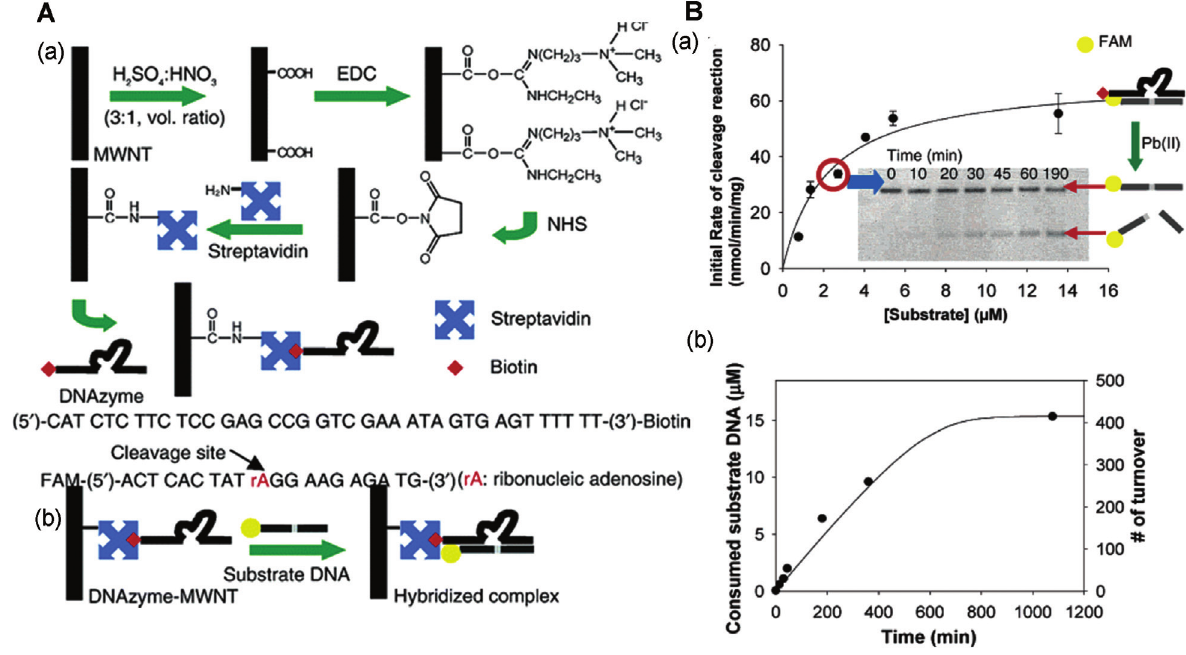
Figure 5 (A): (a) Sequence of the 17E DNAzyme and schematic showing the procedure for immobilizing it onto MWNTs; (b) sequence of 6-carboxyfluorescein (FAM)-bound substrate DNA, which contains a single embedded ribonucleotide (cleavage site), along with a cartoon depicting its hybridization with DNAzyme. (B) Catalytic activity of DNAzyme-MWNT conjugates: (a) initial rate of cleavage of substrate DNA by DNAzyme-MWNT conjugates in the presence of 0.15 mm Pb 2+ ; (b) confirmation of multiple turnovers by DNAzyme catalysis initiated with 0.15 mm Pb 2+ at room temperature. Reprinted with permission from: Yim et al. 2005. Copyright 2005, American Chemical